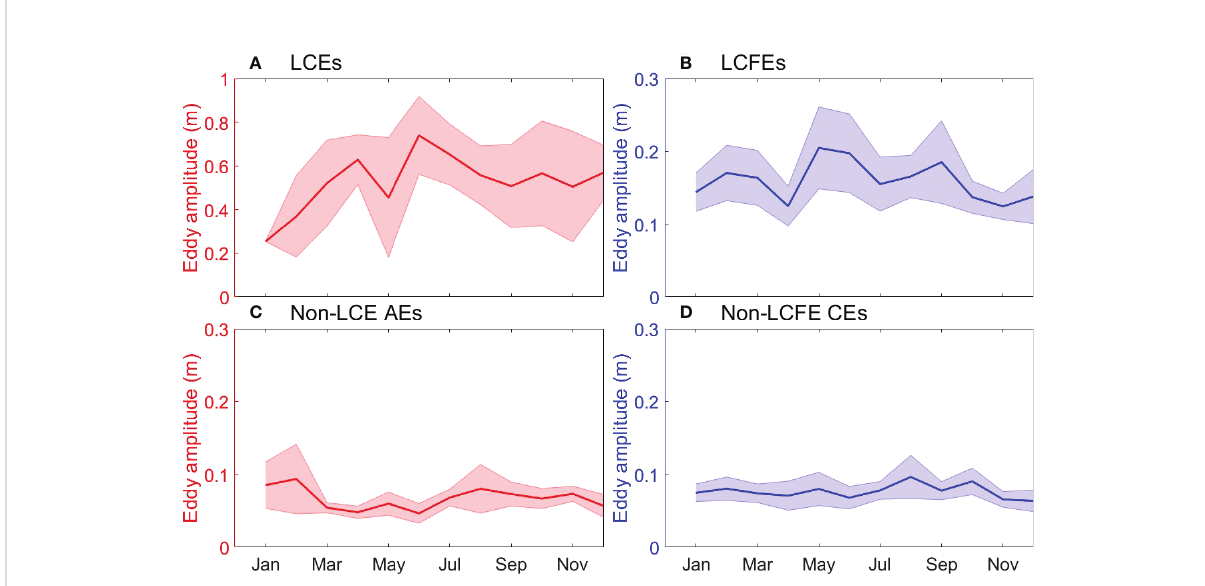
FIGURE 12 Monthly climatology of eddy amplitude of (A) LCEs, (B) LCFEs, (C) non-LCE AEs, and (D) non-LCFE CEs whey they were generated. The shading denotes the 95% con fi dence level represented by two times standard deviation of